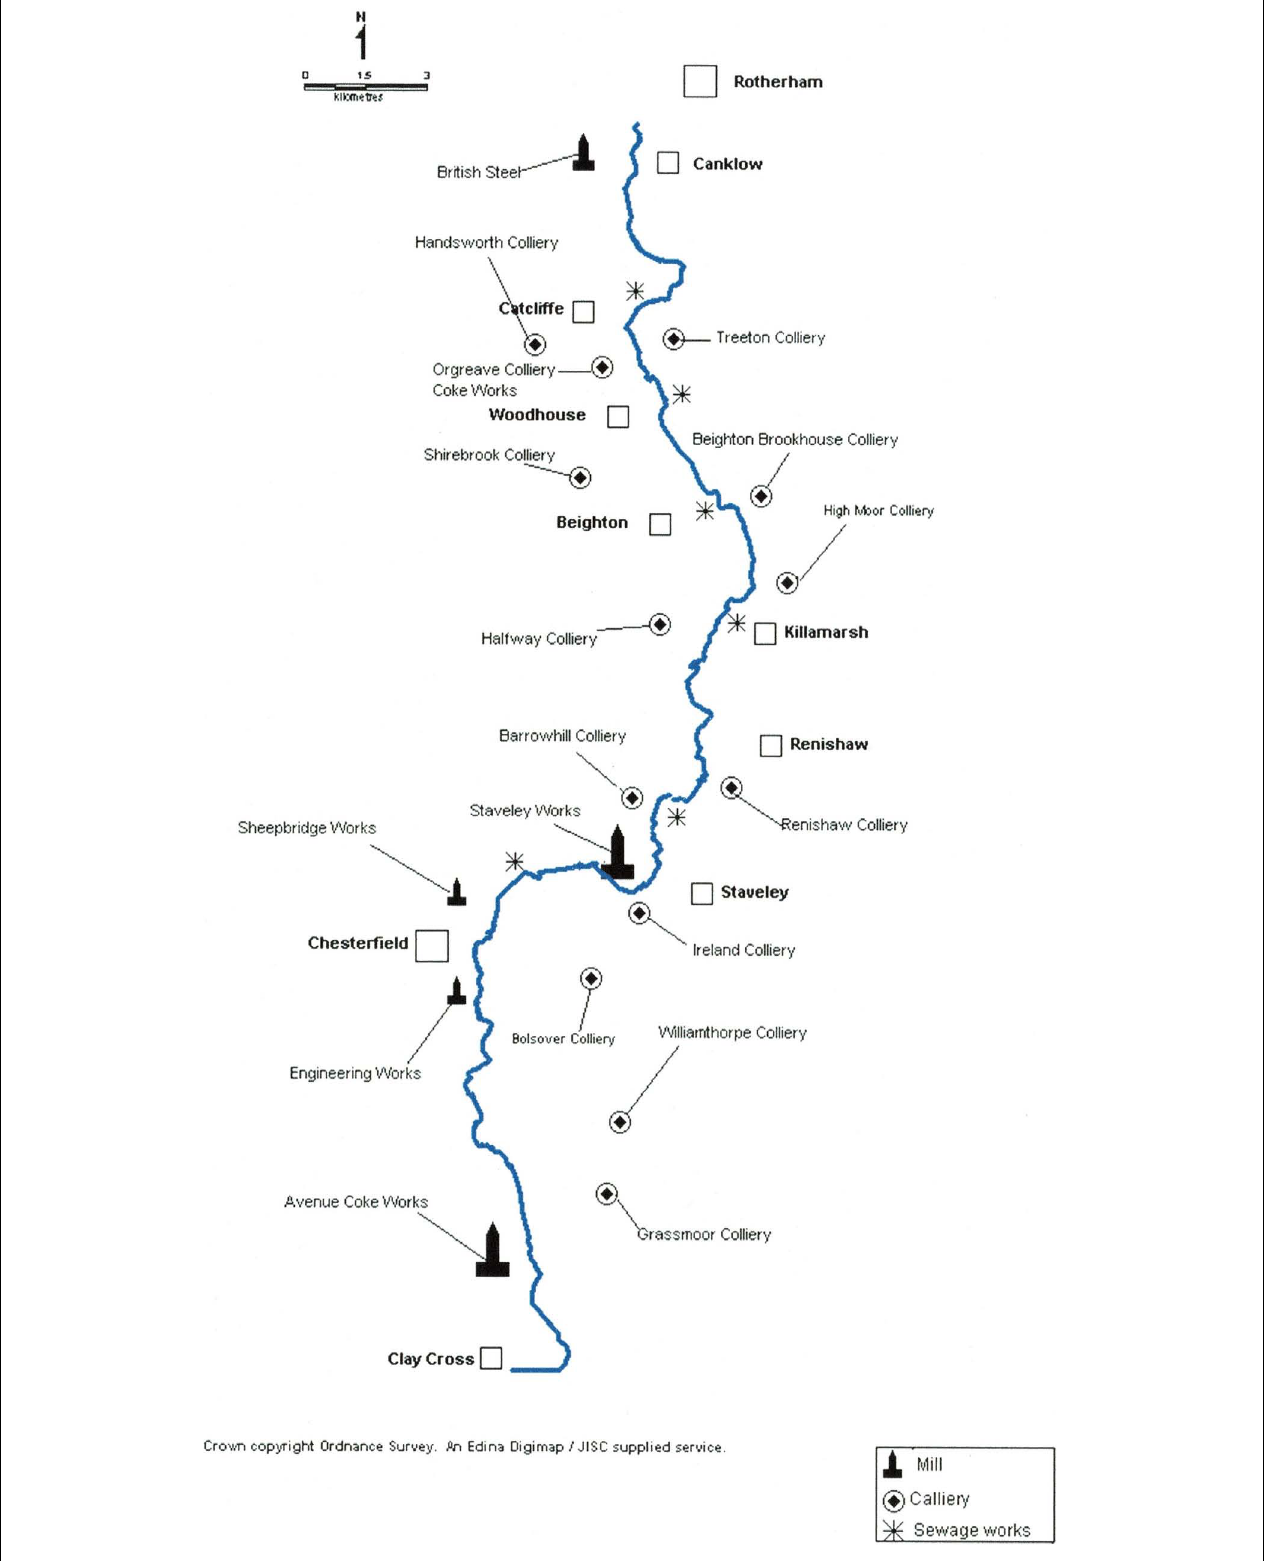
FIGURE 7 | Sources of pollution along the River